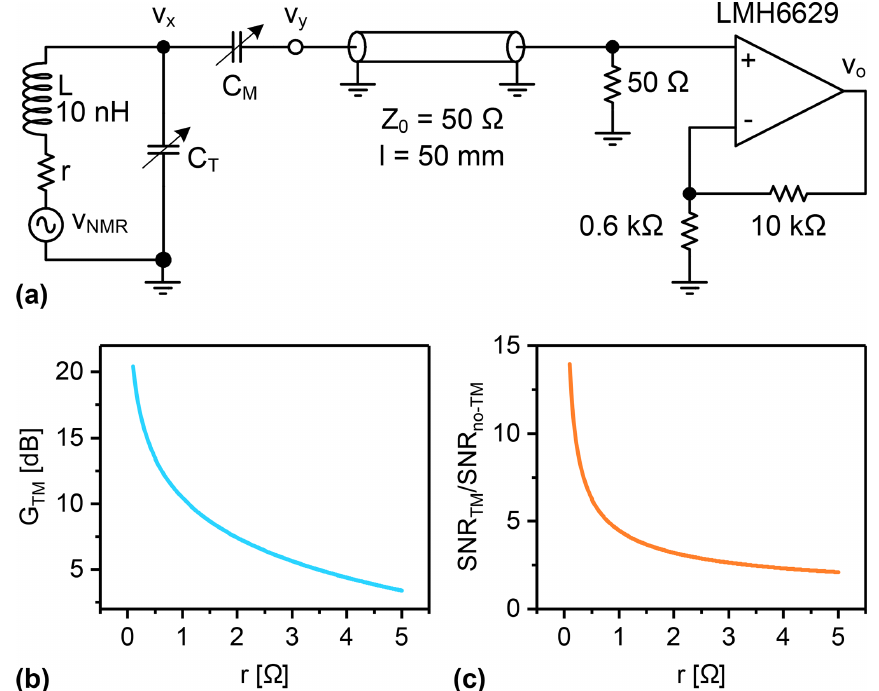
Figure 2. The effect of T&M the NMR coil on the overall signal-to-noise ratio after the receiver. (a) Typical NMR receiver circuit including the coil, T&M capacitors, coaxial cable, and low-noise amplifier. The cable length was set to be short enough so that its attenuation is negligible. (b) The passive amplification, G TM , as a function of the coil’s resistance. (c) The overall SNR enhancement as a function of the coil’s resistance. All simulations were performed using the Advanced Design System (ADS)